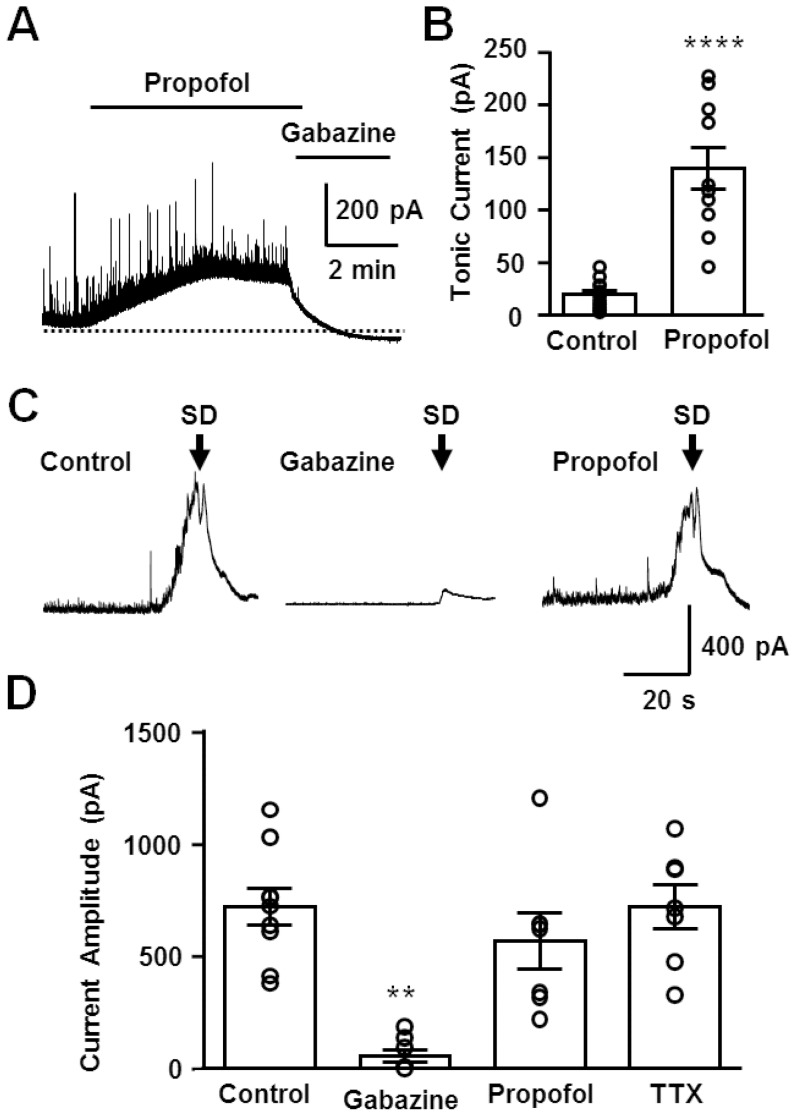
Effects of propofol and gabazine on the large GABAAR current during SD.
A&B Effects of propofol (200 µM) and gabazine (10 µM) on basal GABA transmission. Representative traces (A) and quantitative analysis (B) are shown. ****p<0.001, Control: n = 15, propofol n = 10 C&D Pharmacological characterization of the large GABAAR current during SD. Gabazine nearly completely eliminated the early GABAAR current, while propofol had little effect. Representative traces of early GABAAR currents in control conditions as well as in the presences of gabazine and propofol, at the concentrations used in A&B. The SD onsets are defined by the onsets of extracellular DC shifts and are indicated by the arrows. D. Quantitative analysis of current amplitudes. Current amplitudes were determined from holding currents immediately before SD onset. Control: n = 9, gabazine: n = 8, propofol: n = 7, TTX: n = 7, **p<0.01 compared to others.